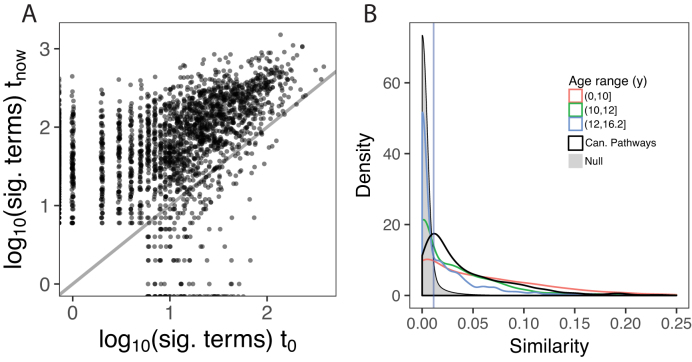
Stability analysis of 2,573 published hit lists. (A) Change in number of significant GO terms. Each point is one CGP hit list. Points are jittered to reduce overplotting. (B) Similarity of enrichment results, using the complete Jaccard index. The CGP hit lists are binned into most recent (orange), old (green), and oldest (blue). The distribution for the CPs is in black. The blue vertical line indicates the 95%ile of the null.